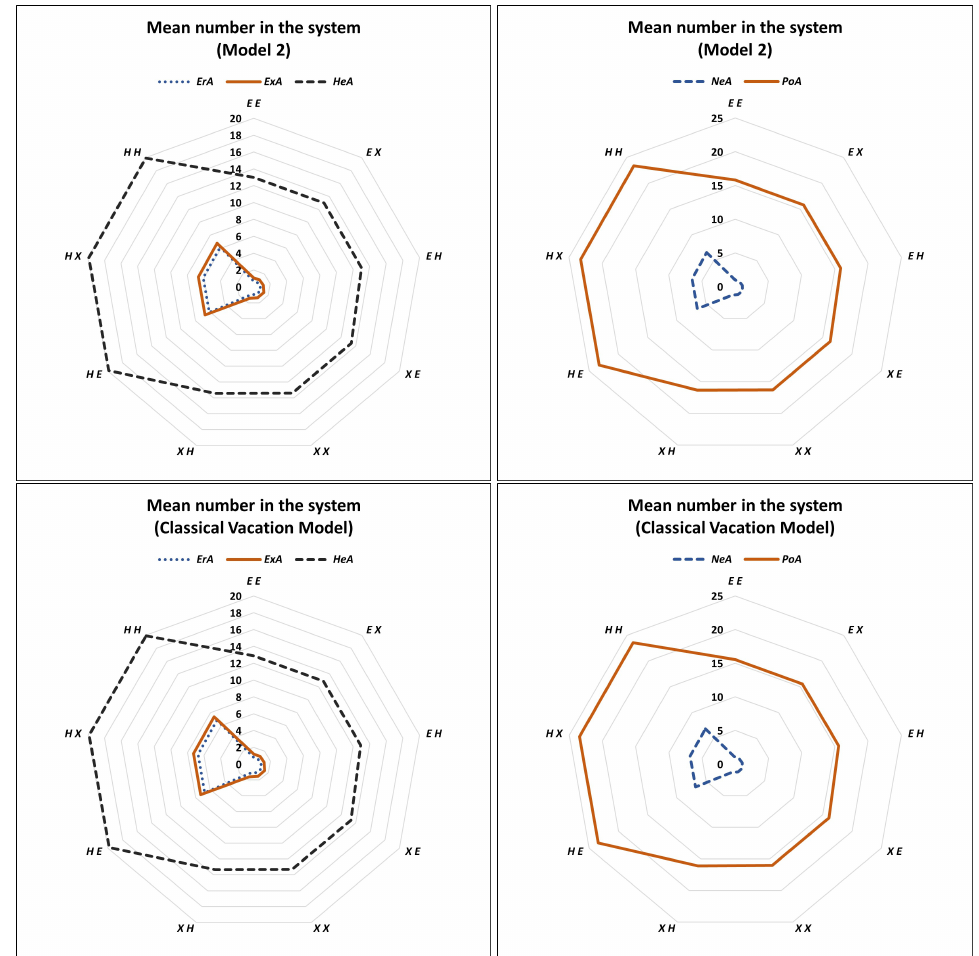
Figure 4. Mean number of customers in the system for Model 2 under various